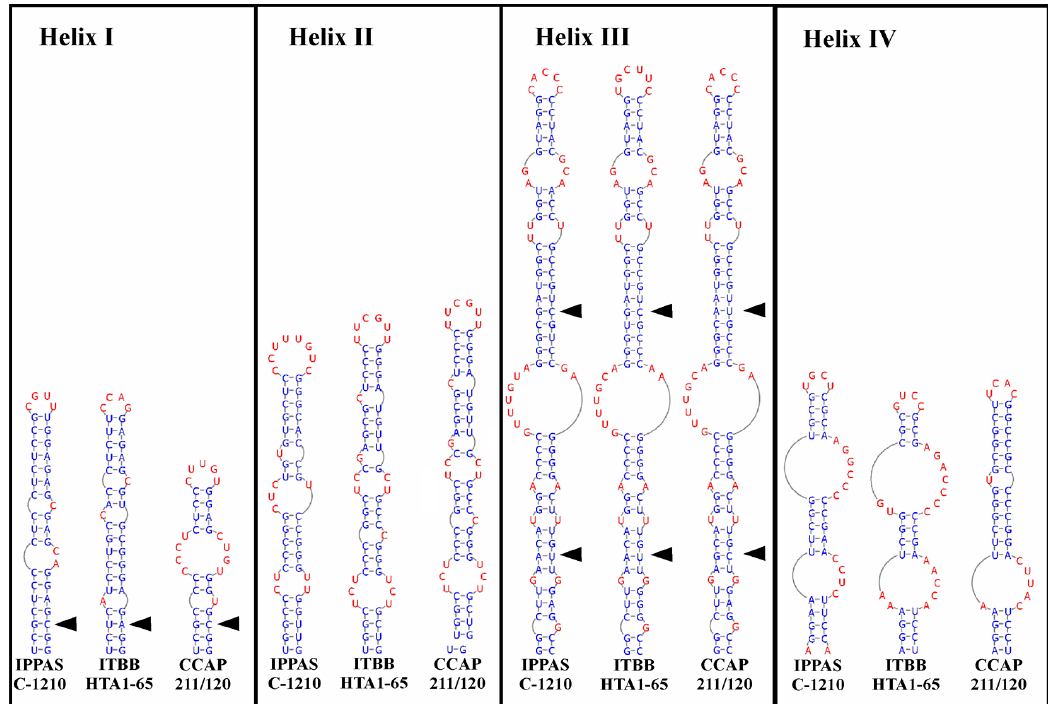
Figure 5. ITS2 secondary structure of Neochlorella semenenkoi . IPPAS C-1210, N. thermophila ITBB HTA 1–65, and C. volutis CCAP 211/120. Black arrow—CBC.